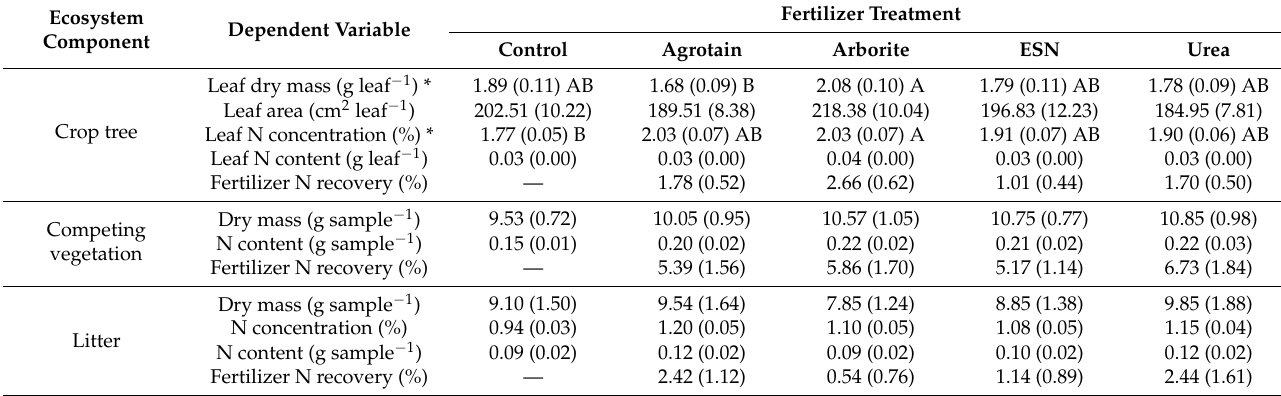
Table 2. Mean values ( ± standard error of the mean) for plant-related response variables for which no interaction was observed, by fertilization treatment. For crop tree variables, values displayed are fertilizer treatment means ( n = 8). For competing vegetation and litter variables, values displayed are fertilizer treatment means ( n = 8), with each sample being represented by four 0.0625 m 2 sub-sampling areas surrounding each crop tree from which all vegetation and litter was collected at each sampling time. Fertilizer N recovery values are the percentage of fertilizer-derived 15 N recovered from the specified component in each fertilizer treatment relative to the amount initially